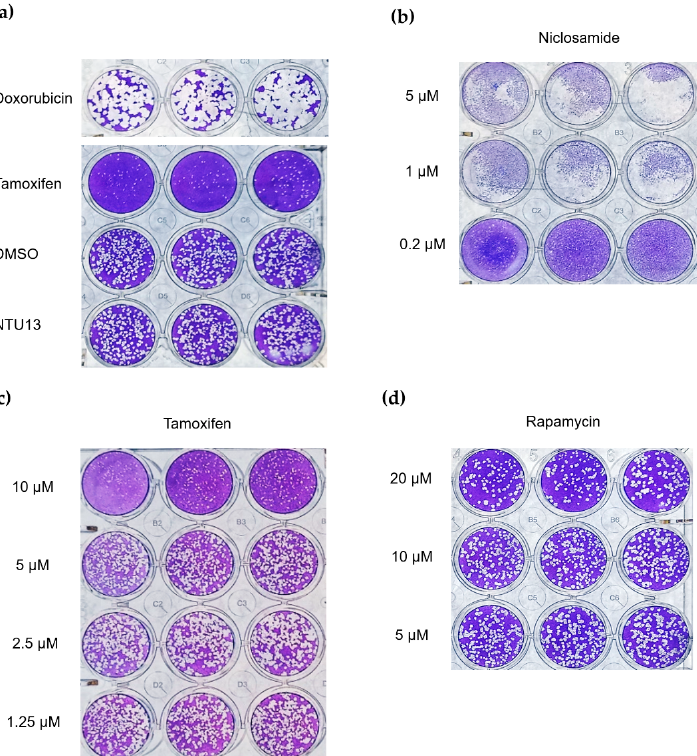
Figure 7. Plaque reduction assay for the candidate compounds. Infected cells were treated with in- dividual compounds for 120 h to evaluate the antiviral activity. ( a ) Treatment with six compounds at a concentration of 10 μ M. ( b ) Treatment with niclosamide at three concentrations. ( c ) Treatment with tamoxifen at four concentrations. ( d ) Treatment with rapamycin at three concentrations.